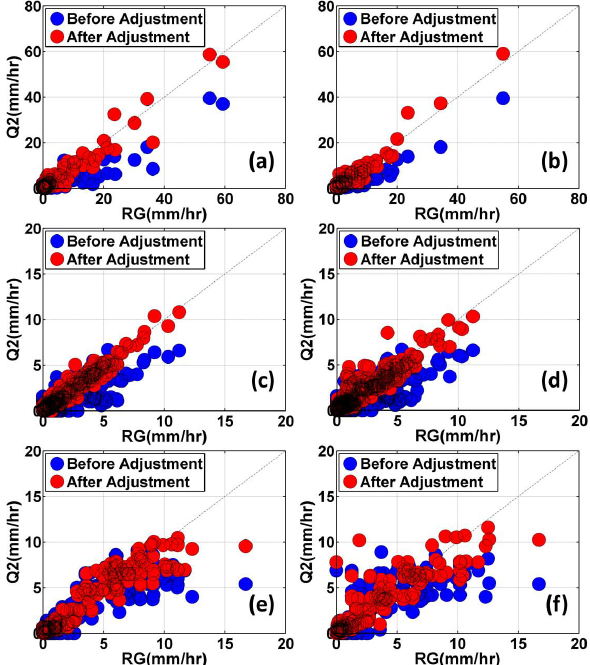
Fig. 4. Comparison of hourly precipitation rate (mmh − 1 ) between rain gauge observations and Q2 estimations before and after adjust- ment during 12 to 17 July 2011 for CCB (a) and BCB (b) , during 5 to 10 January 2009 for CCB (c) and JCB (d) , and during 6 to 11 December 2009 for CCB (e) and JCB (f)